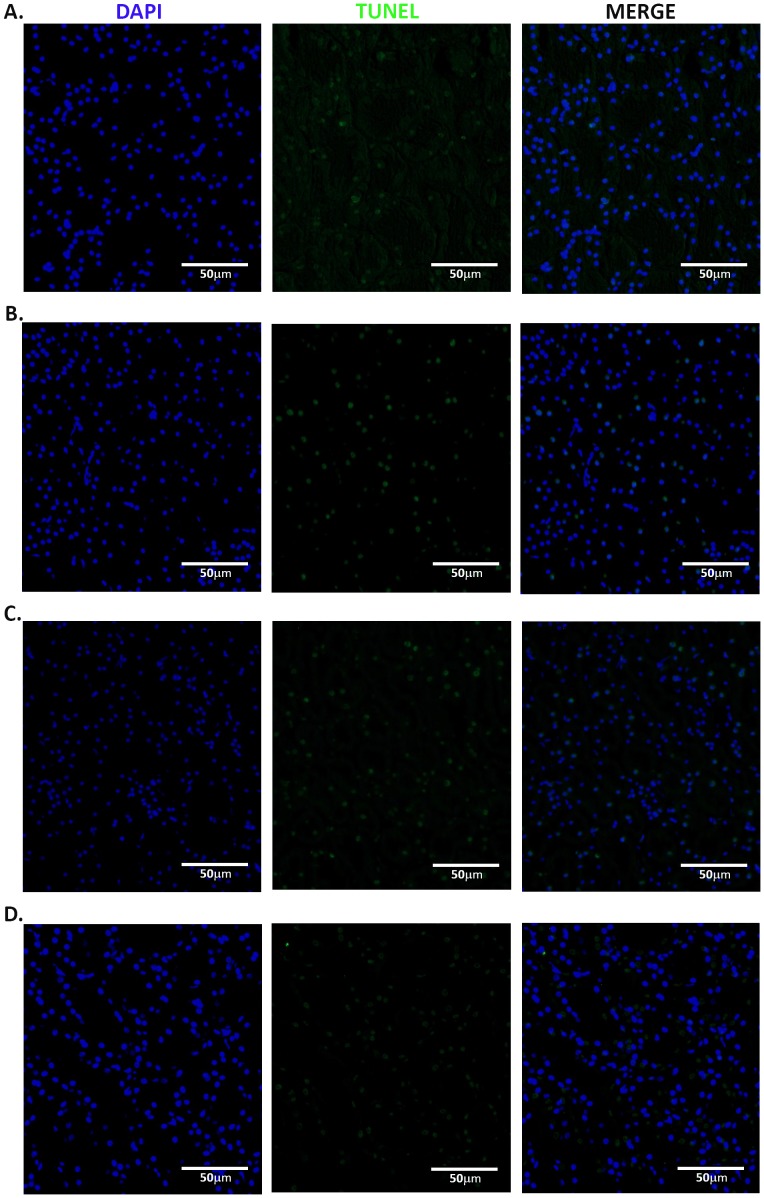
Tubular TUNEL assay consisting of DAPI (nuclei), fluorescein (apoptotic marker), and merged sections for each group (vehicle+vehicle (A); vehicle+celecoxib (B); misoprostol+misoprostol (C); misoprostol+celecoxib (D)), 20x magnification.